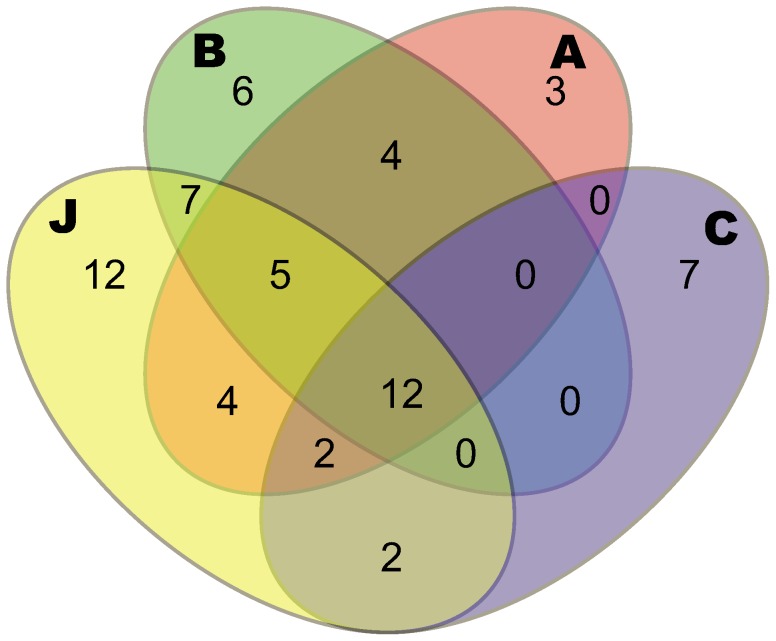
Venn diagram representing shared and unique restriction fragment length polymorphisms (RFLP) groups for denitrifying communities.The groups were detected by screening ∼100 nosZ gene clones retrived from soil communities A–C and J. Community A had 30, B had 34, C had 23 and J had 44 of the 64 groups in total.